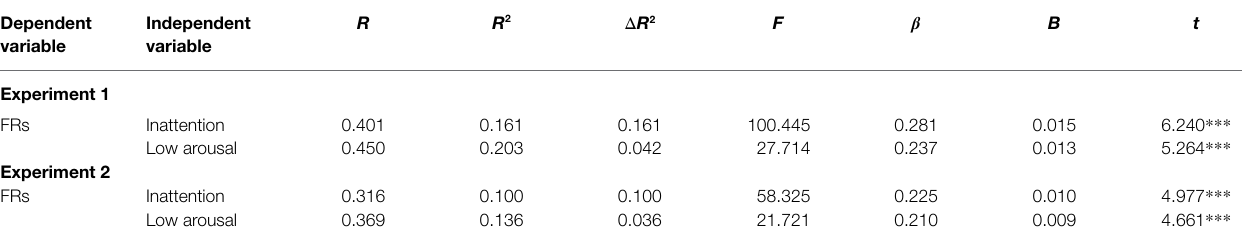
TABLE 3 | Stepwise regression analysis of the use of state boredom and FR.